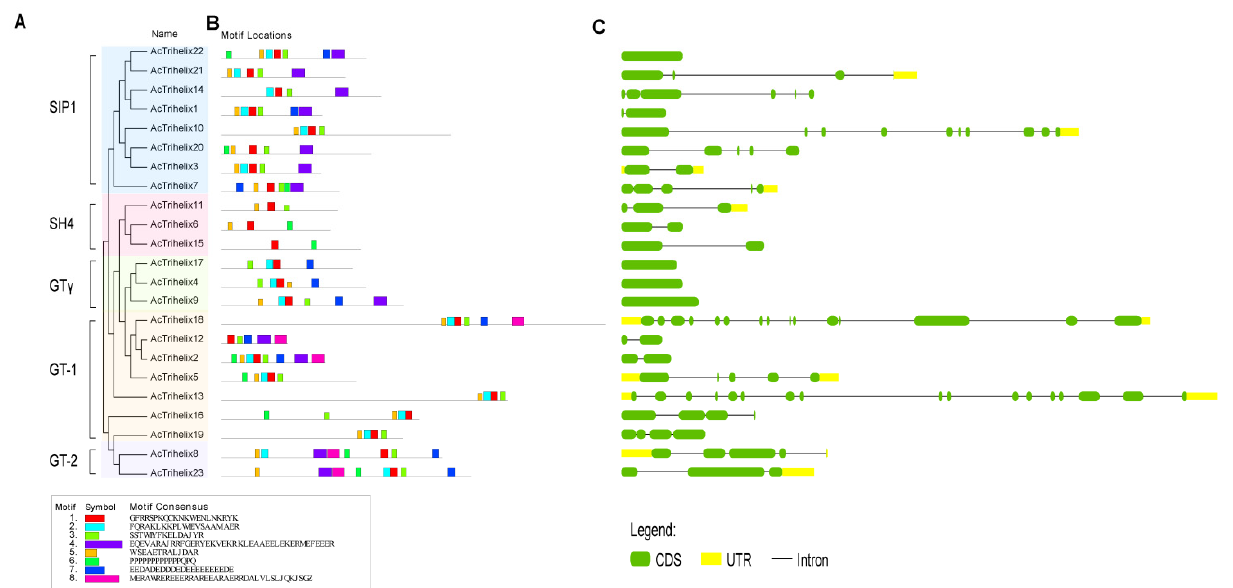
Figure 2. Phylogenetic relationships and gene structures of the 23 AcTrihelix genes: ( A ) neighbor- Joining tree analysis of Trihelix family in pineapple; ( B ) the distributions of the predicted motifs in the AcTrihelix proteins; ( C ) gene structures of pineapple Trihelix family. The yellow icon means UTR (untranslated region), the green icon means CDS (coding sequence), and the line between UTR and CDS means intron (a noncoding part of a gene or mRNA molecule).